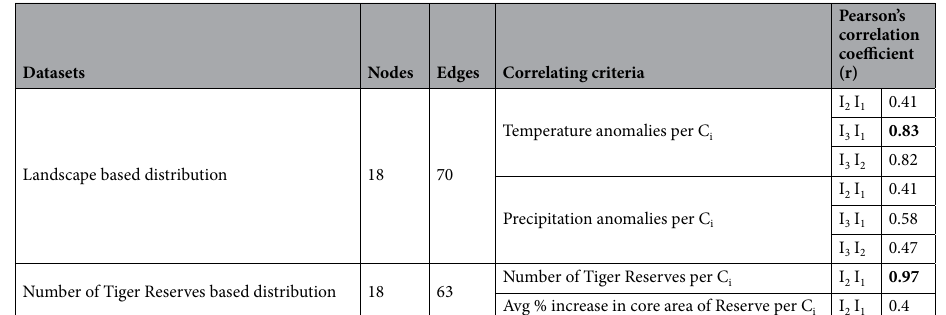
Pearson’s correlation coefficient (r)